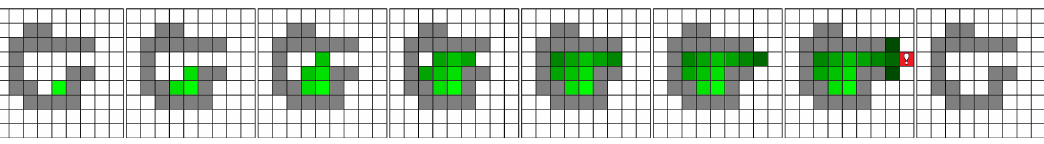
Figure 7. Filling an open area. Gray areas denote voxels of the surface; green denotes voxels filling the internal voids of the approximating model; and red zones indicate contact with the boundary of the region to be approximated.